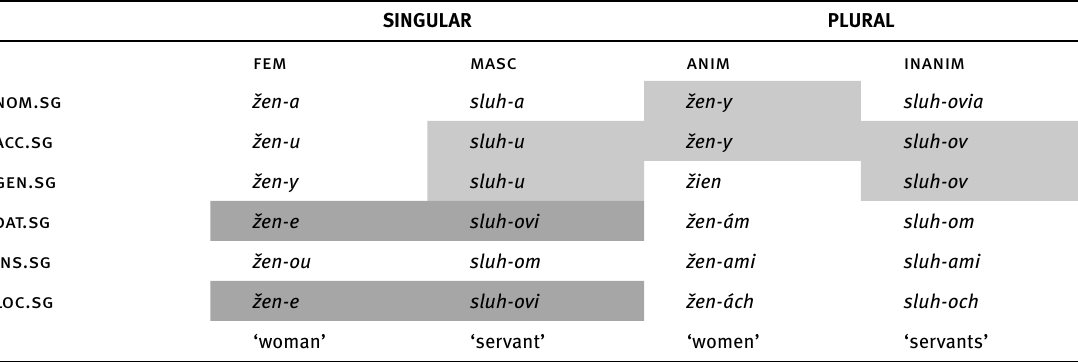
Table 7. Feminine and masculine paradigms of * ā -stems in Slovak